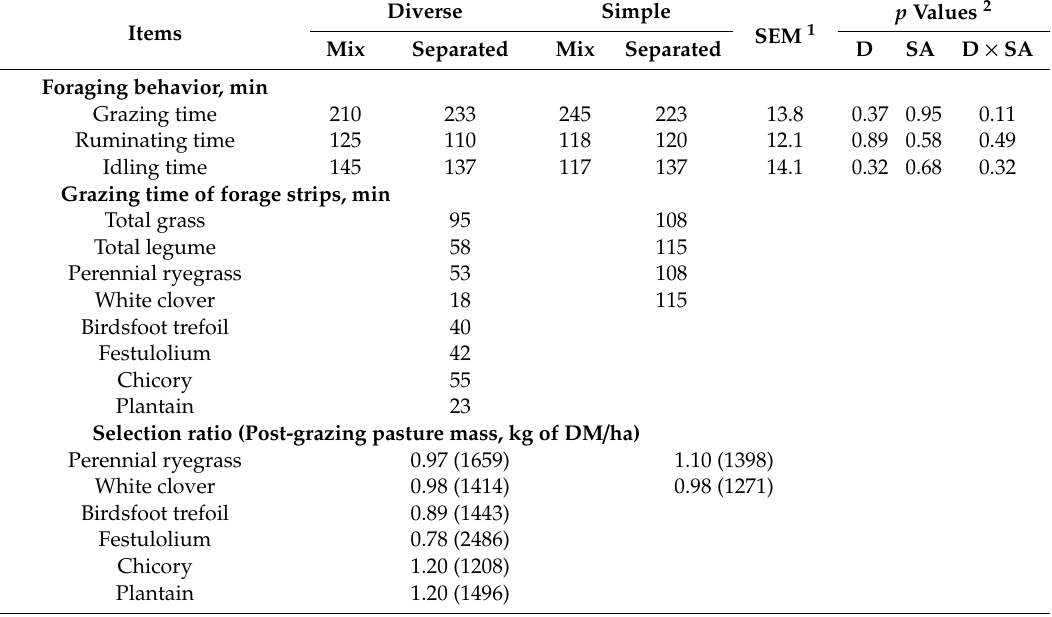
p Values 2 SEM 1